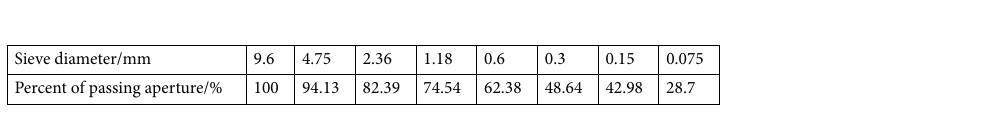
Table 2. Grain size distribution of